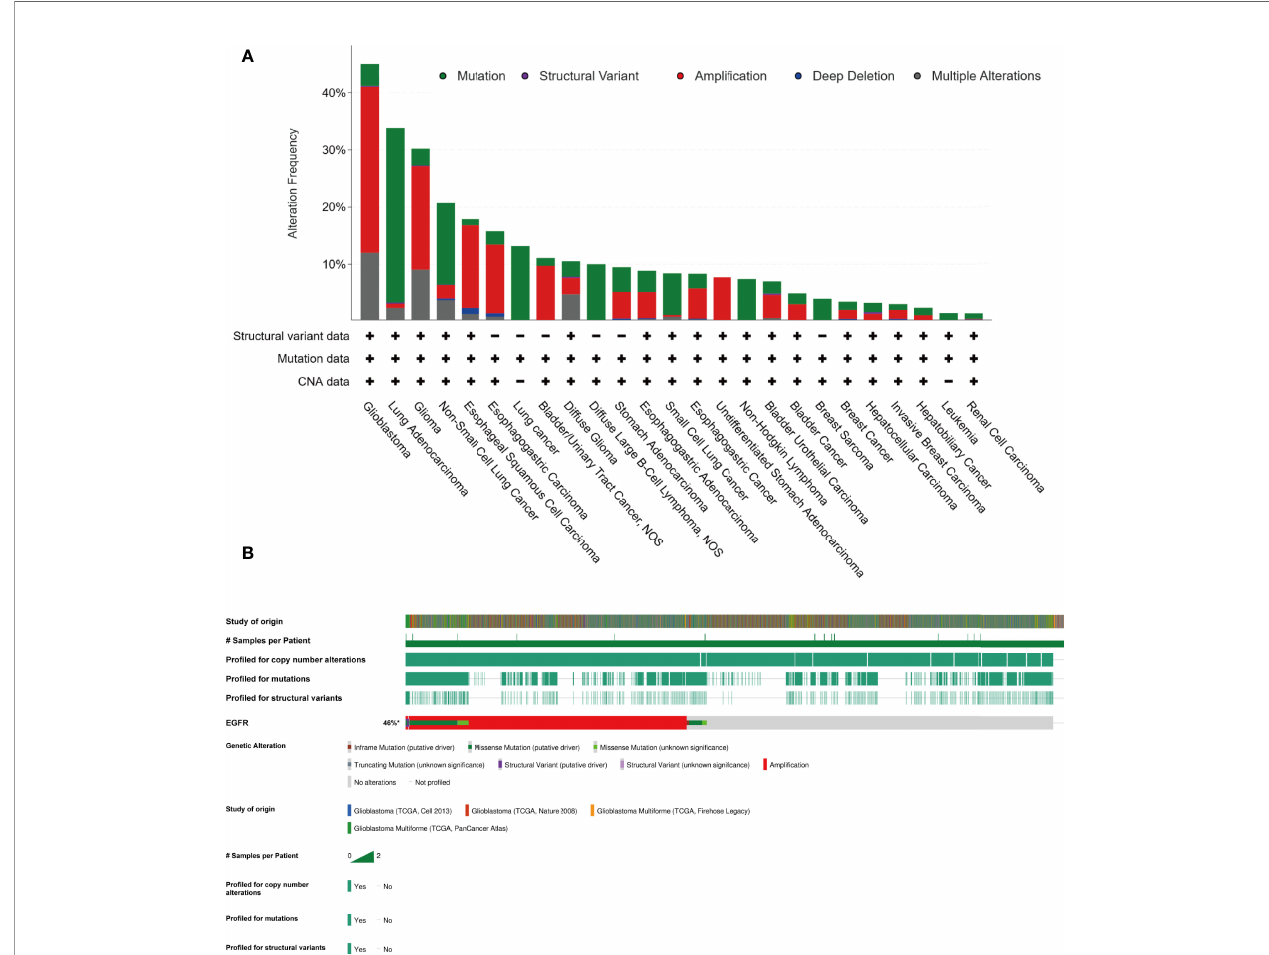
FIGURE 4 | In contrast to lung cancer, glioma majorly harboring ampli fi cation of EGFR, instead of nucleotide mutation (cBioPortal). (A) The EGFR alteration frequency in different tumor types based on the PanCancer study “ Pan-cancer analysis of whole genomes (ICGC/TCGA, Nature 2020) ” in cBioportal database. (B) The collection of genetic alteration of EGFR based on four different studies in cBioportal